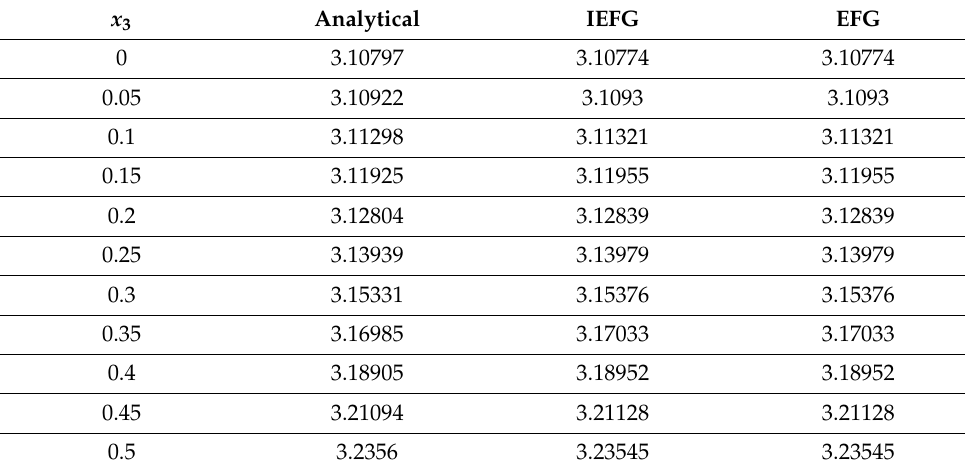
Table 4. The exact and numerical solutions of u (2/20, 9/20, x 3 ).